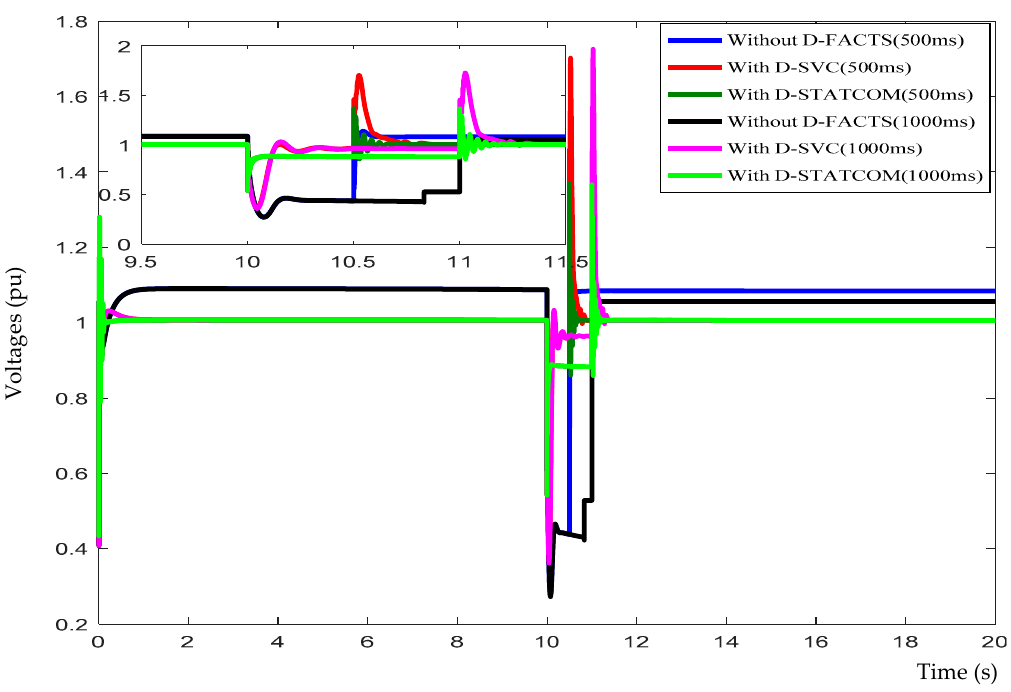
Figure 16. Voltages at the PCC during the voltage drop at the 60 kV bus.